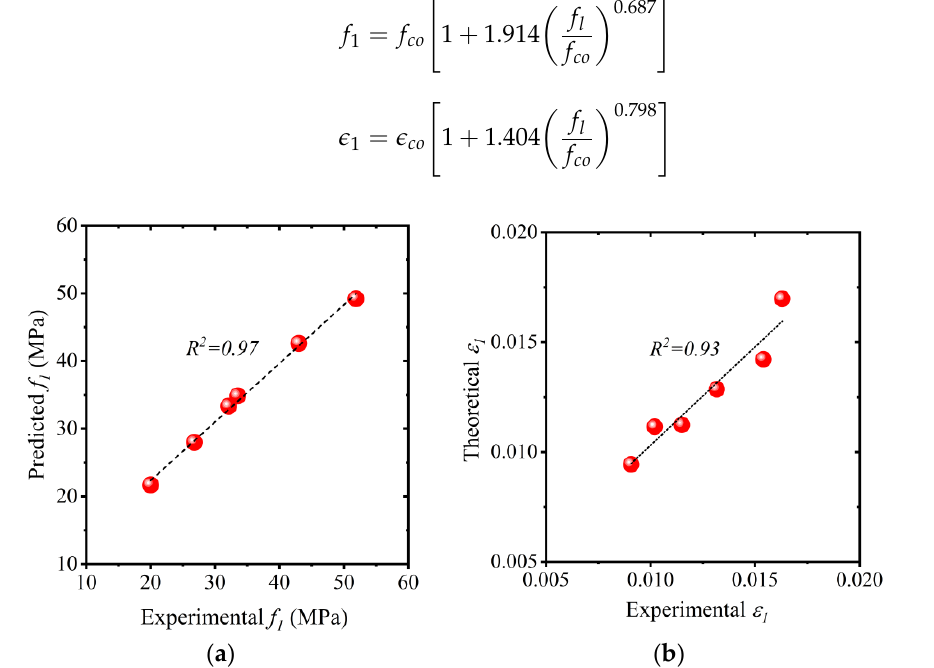
Figure 19. Comparison of experimental vs. predicted ( a ) 𝑓 1 values and ( b ) 𝜖 1 values.